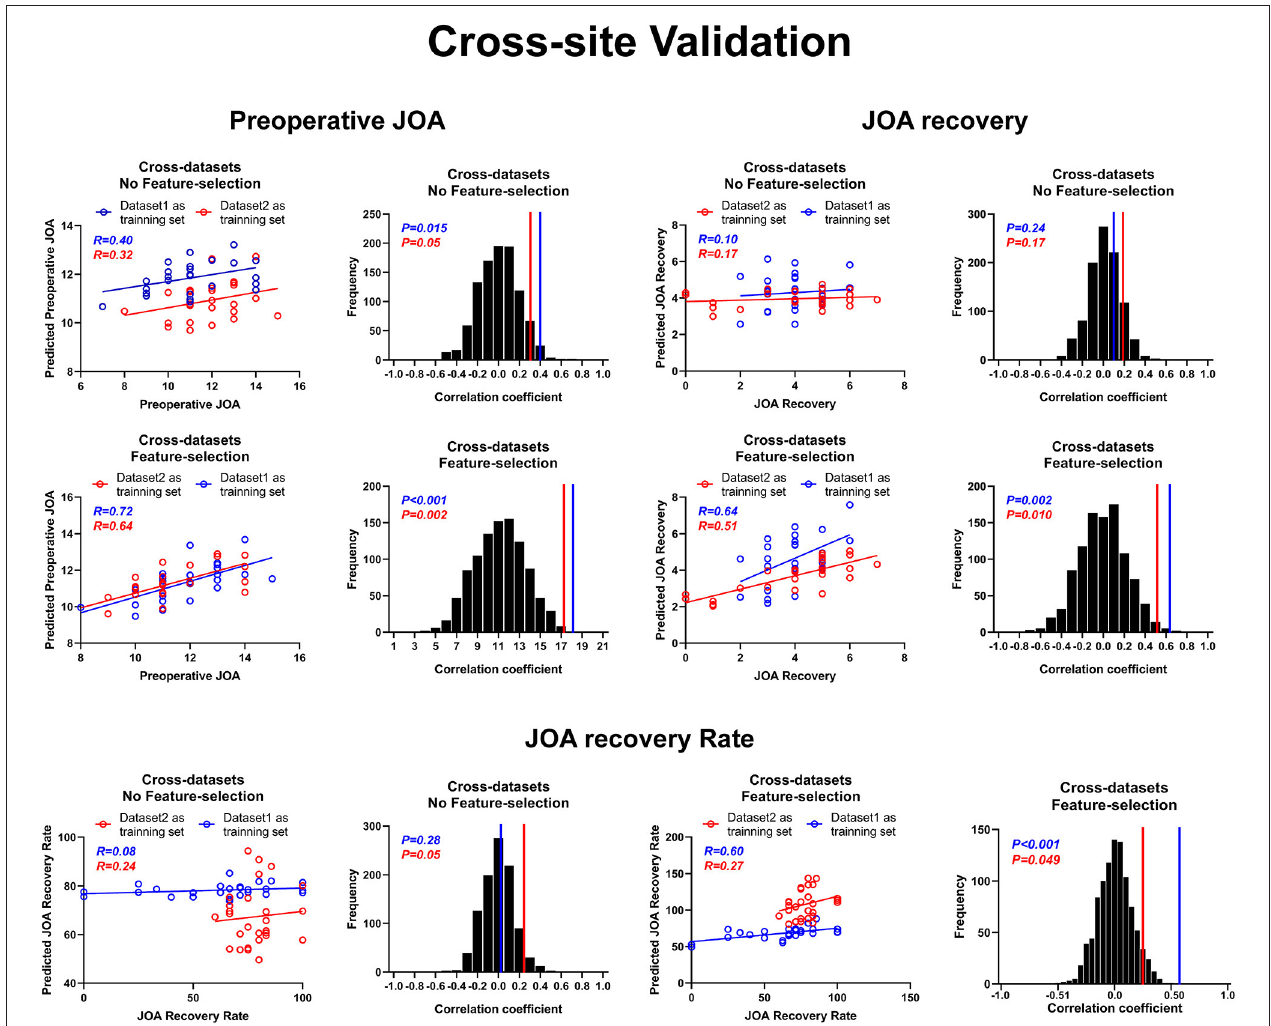
FIGURE 6 | Cross-site validation for prediction analyses. Cross-site validation of the prediction of both preoperative JOA scores and JOA recovery. JOA, Japanese Orthopedic Association. JOA recovery = postoperative JOA scores minus preoperative JOA scores.